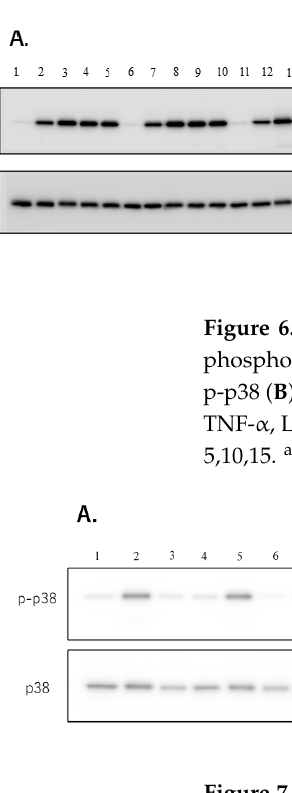
Figure 7. Effect of jietacin derivative on the p38 pathway in human primary synovial fibroblasts. Western blotting for p38, phosphorylated p38 (p-p38), and GAPDH ( A ). Densitometry of Western blot protein bands for p-p38 ( B ) and p38 ( C ) were normalized to the expression of GAPDH ( n = 3). Vehicle, Lane 1,4,7; TNF- α, Lane 2,5,8; TNF- α+ 2.5 JD , Lane 3,6,9. a p < 0.05 compared with vehicle.